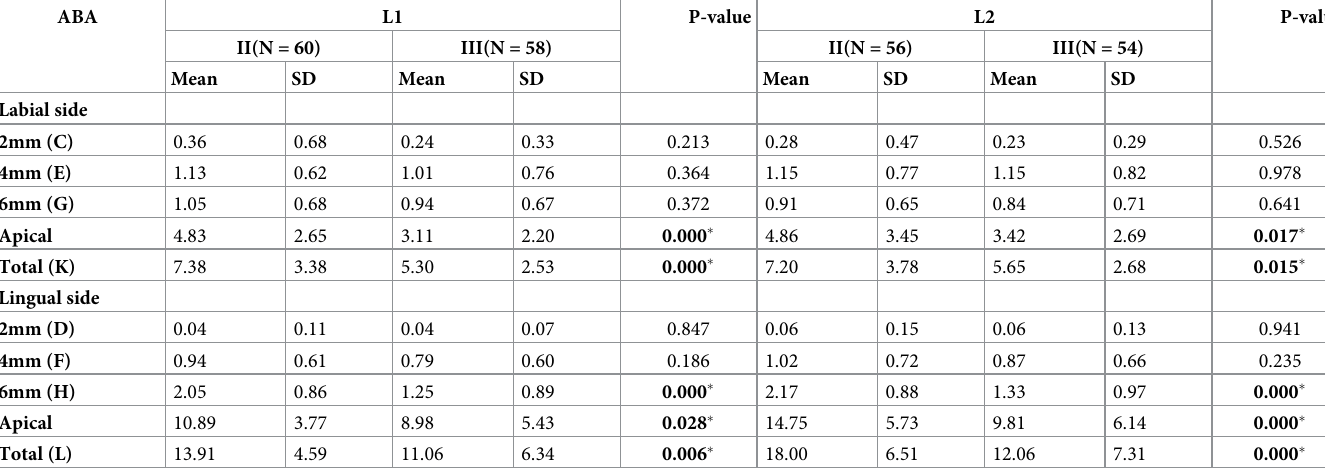
total ABA on the labial and lingual sides, and ABA at 6 mm below the CEJ level on the lingual side (P < 0.05). No statistically significant differences were found in the area 2 mm or 4 mm below the CEJ level on the labial and lingual side, and in the area 6 mm below the CEJ level on the labial side between the 2 groups (P > 0.05). Thickness difference of the alveolar bone In the third step, we investigated the thickness of the alveolar bone of the upper and lower inci- sors between high-angle skeletal Class II malocclusion patients and high-angle skeletal Class Table 6. Comparison of mandibular alveolar bone area between skeletal Class II malocclusion patients and skeletal Class III malocclusion patients (mm 2 ). ABA L1 P-value